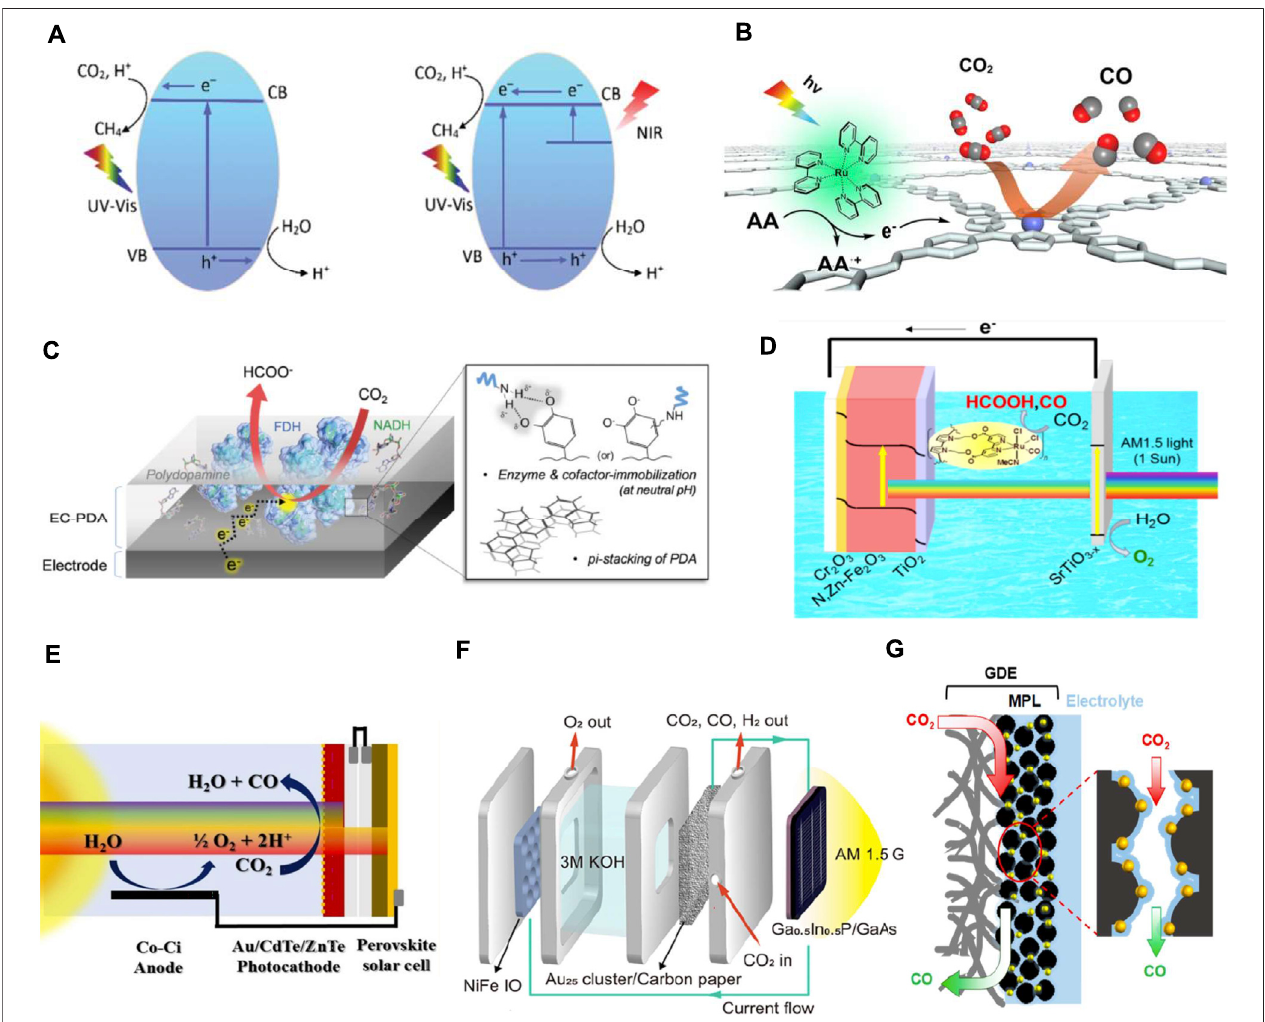
FIGURE 2 | (A) Mechanisms for photocatalytic CO 2 reduction over pristine and oxygen-de fi cient bismuth tungstate (Kong et al., 2016), (B) Mechanisms for photoreductionofCO 2 intoCOoverCOF-367-Conanosheetswith[Ru(bpy) 3 ] 2+ asphotosensitizerandascorbicacidaselectrondonor(Liuetal.,2019). (C) Biocathode thin fi lm derived from a polydopamine (PDA) matrix copolymerized with an enzyme (FDH) and its cofactor (NADH) (Lee et al., 2016), (D) Dual-electrodes PEC – PEC tandemcellconsistingaSrTiO 3-x photoanode andRu(MeCN)CO 2 C3Py-P/TiO 2 /N,Zn-Fe 2 O 3 /Cr 2 O 3 photocathode(Sekizawaetal.,2018). (E) PV – PECtandemcell comprising an Au-CdTe@ZnTe@ZnO NR photocathode-perovskite solar cell and a cobalt bicarbonate (Co-Ci) anode (Jang et al., 2016), (F) PV – GDE-based fl ow electrolyser cell employing NiFe anode and Au 25 cathode (Kim B. et al., 2019), (G) Schematic of CO 2 reduction reaction on Au 25 -anchored GDE (MPL (cid:1) microporous layer) (Cheng et al., 2020).